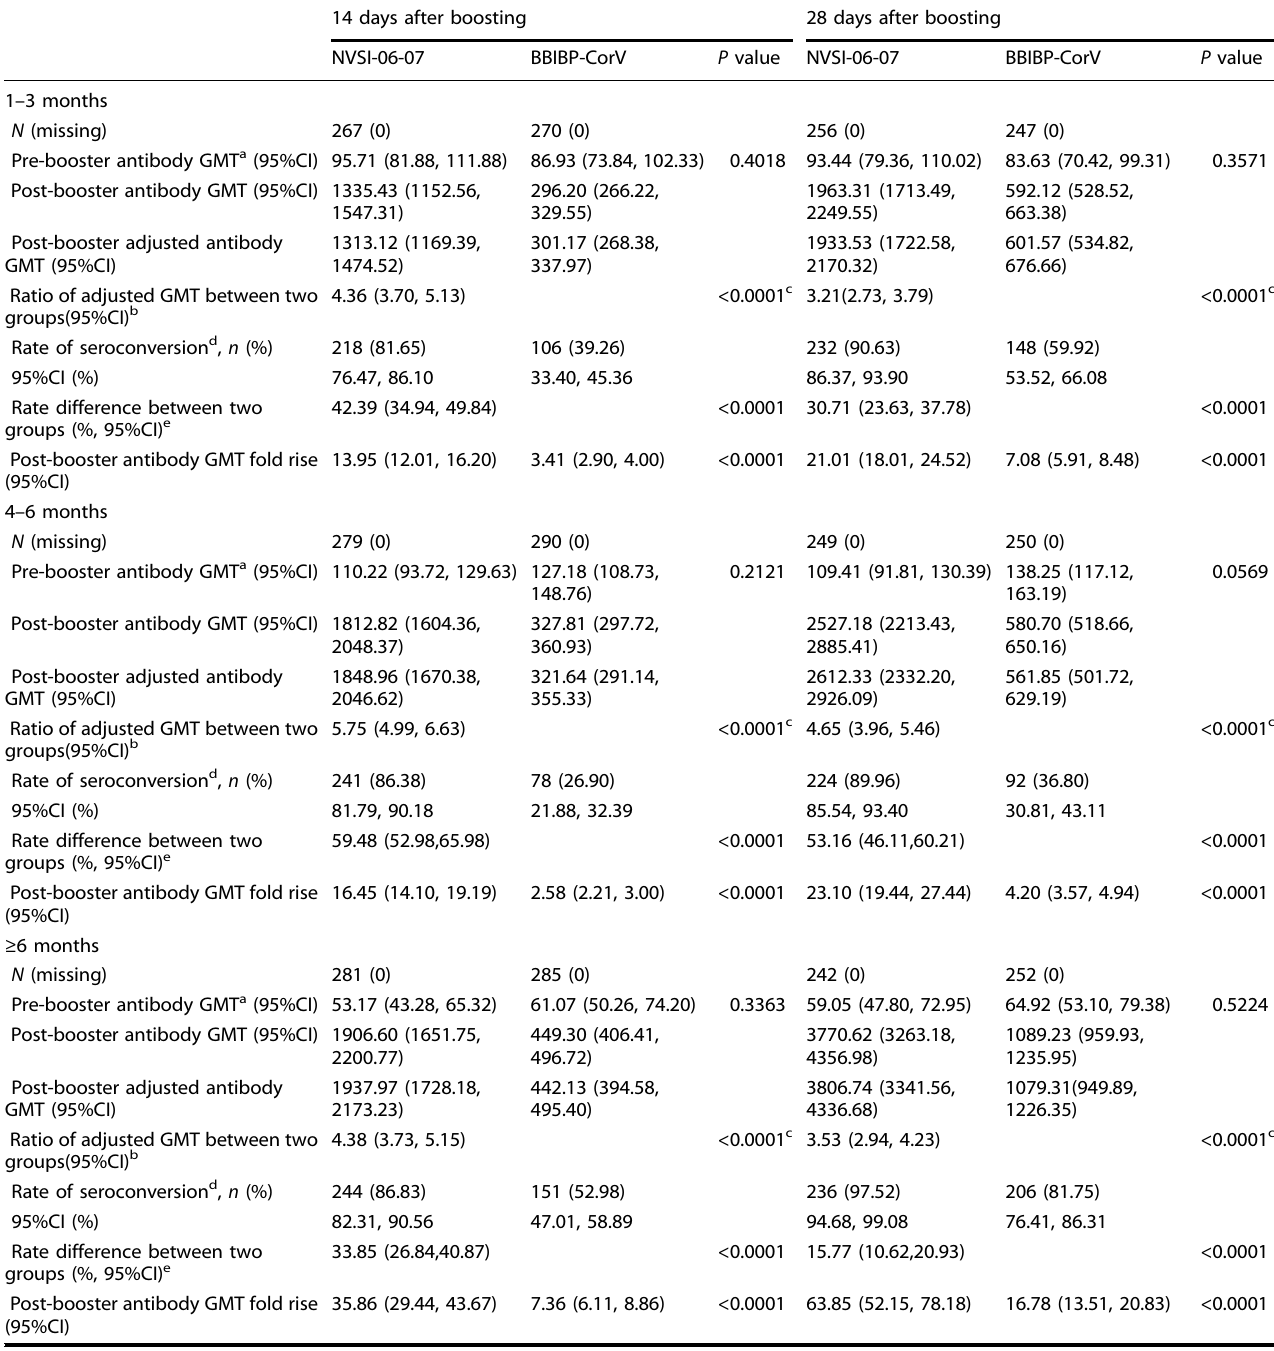
Table 3. Live-virus neutralizing antibody response results